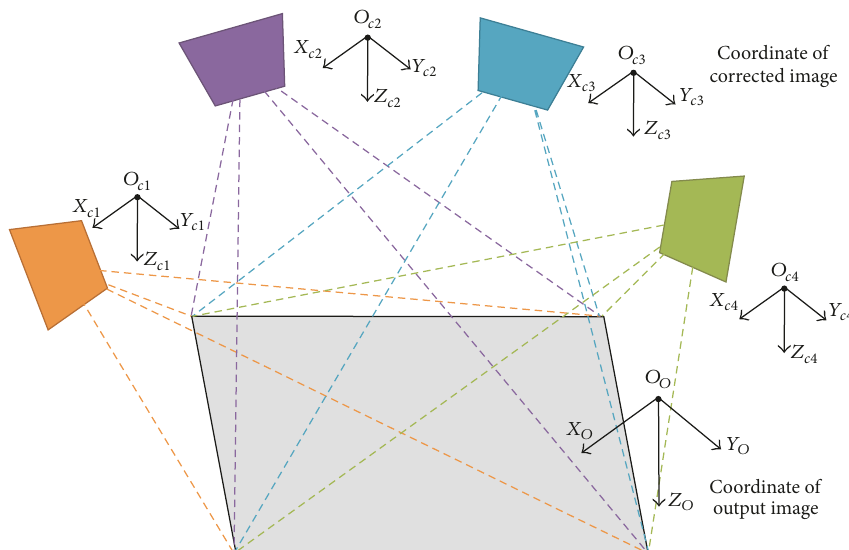
Figure 3: The illustration of image registration and coordinate